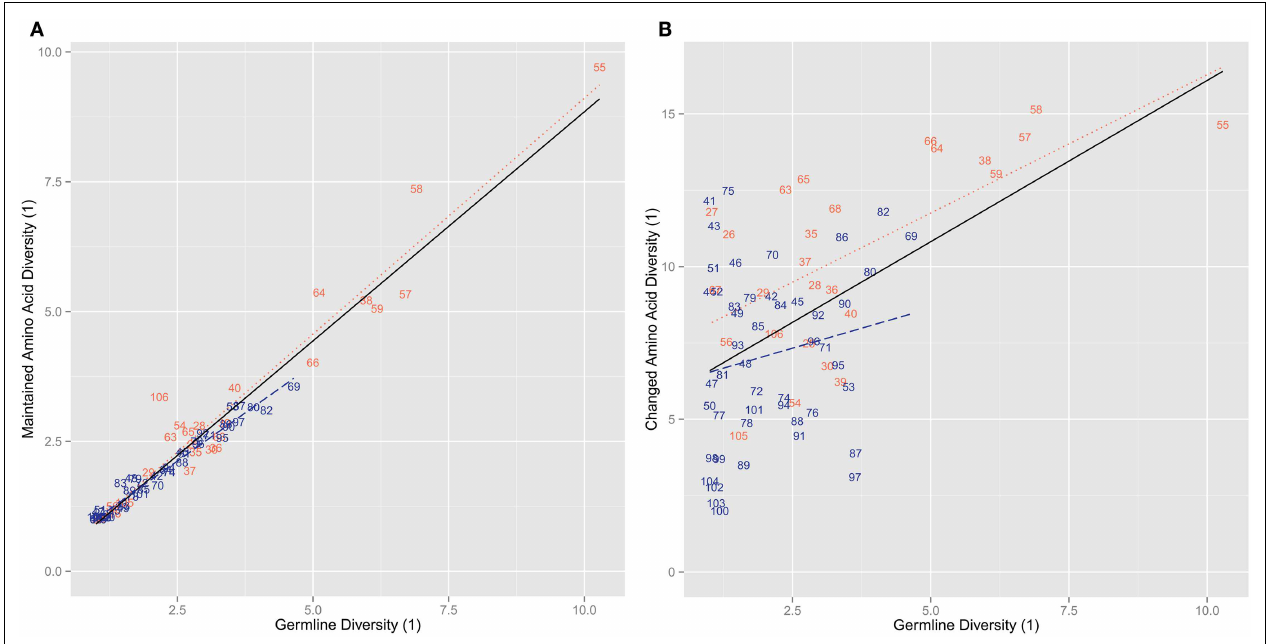
FIGURE 3 |The diversity of order 1 of the amino acids versus the diversity of order 1 for the germline sequences per position . (A) The diversity of order 1 amino acid usage in amino acids positions.We found a significant positive correlation ( r 2 = 0.947, ρ = 0.961, p = 7.52 × 10 − 42 ).We also found positive correlations when the positions were split by region for FR ( r 2 = 0.970, ρ = 0.968, p = 3.67 × 10 − 29 ) and CDR ( r 2 = 0.937, ρ = 0.880,